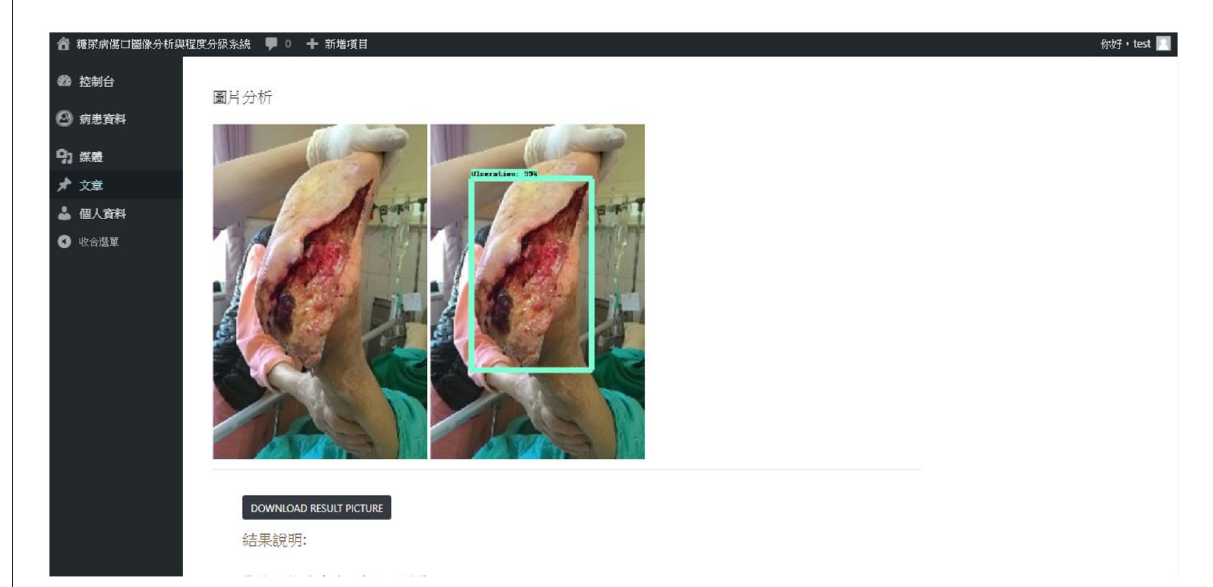
FIGURE15 The webpage shows the identification analysis result.